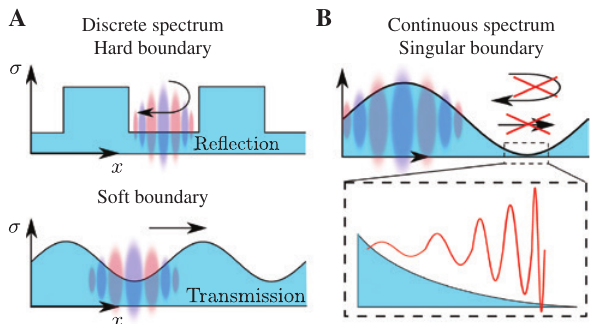
Figure 1: Traveling towards a geometrical singularity, a wave is unable to be reflected or transmitted, becoming increasingly compressed. (A) The in-plane scattering of an electromagnetic wave in a periodic system, e.g. a plasmon propagating along a periodically modulated conductive surface is typically dominated by reflection at hard boundaries or transmission through soft boundaries, leading to discrete Fabry–Pérot modes or Bloch waves, respectively. (B) At a singular boundary, both transmission and reflection channels are virtually inaccessible, and the only available path for a wave is to shrink its wavelength and concentrate its energy as it travels toward the singular